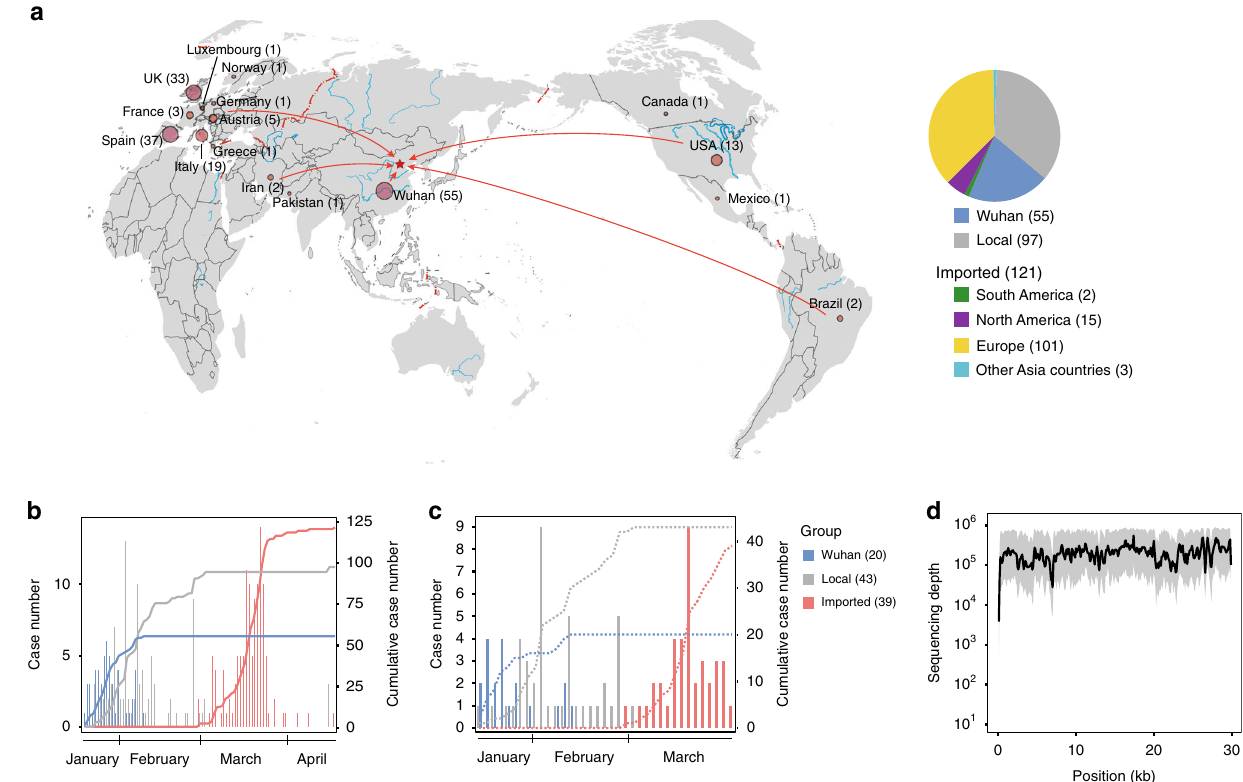
Fig. 1 The COVID-19 cases in Beijing and sequenced in this study. a The geographic sources of the cases in our hospital. b The number of cases in Wuhan group (from or passed by Wuhan), local group (onset locally and without Wuhan or overseas travel history), and imported group (overseas imported) in our hospital. The histograms represent the daily case numbers and the lines show cumulative case numbers in the three groups. c The number of well- sequenced cases ( n = 102). The histograms represent the sequenced case numbers on each day and the orange line shows the cumulative case numbers. d The average sequencing coverage among the sequenced cases ( n = 102). The shadow represents the lower and upper quartiles. Source data are provided as a Source Data fi